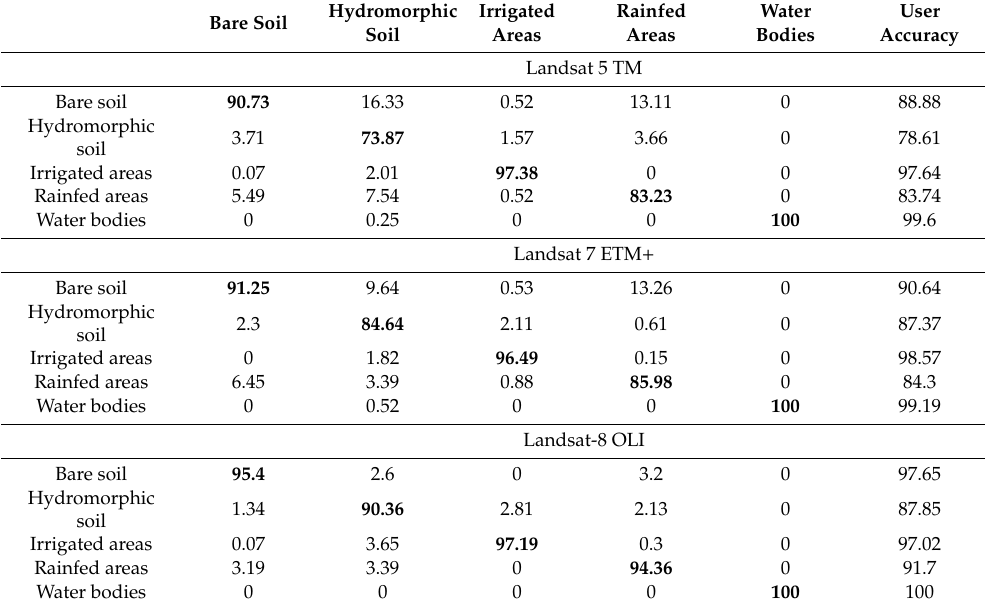
Table 3. Classification accuracy (expressed in %) before pixel trajectory corrections for each of the LULC classes in the Mogtedo region, Burkina